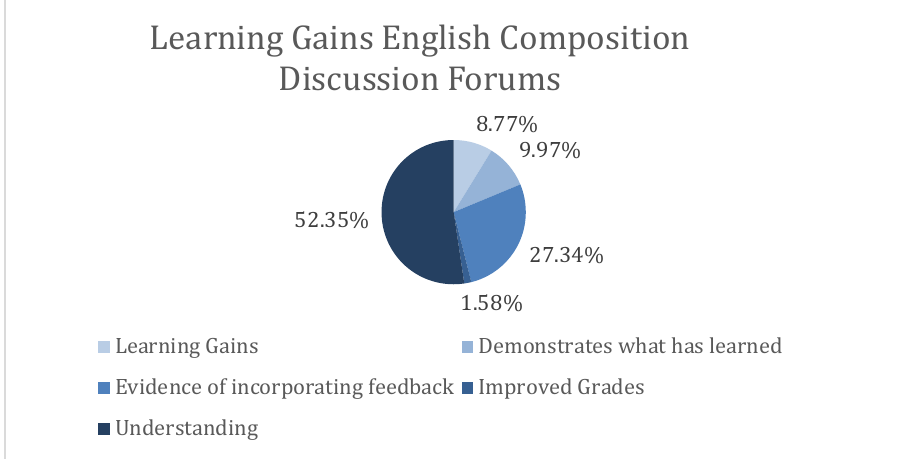
Figure 4 . Coding to learning gains in English Composition discussion